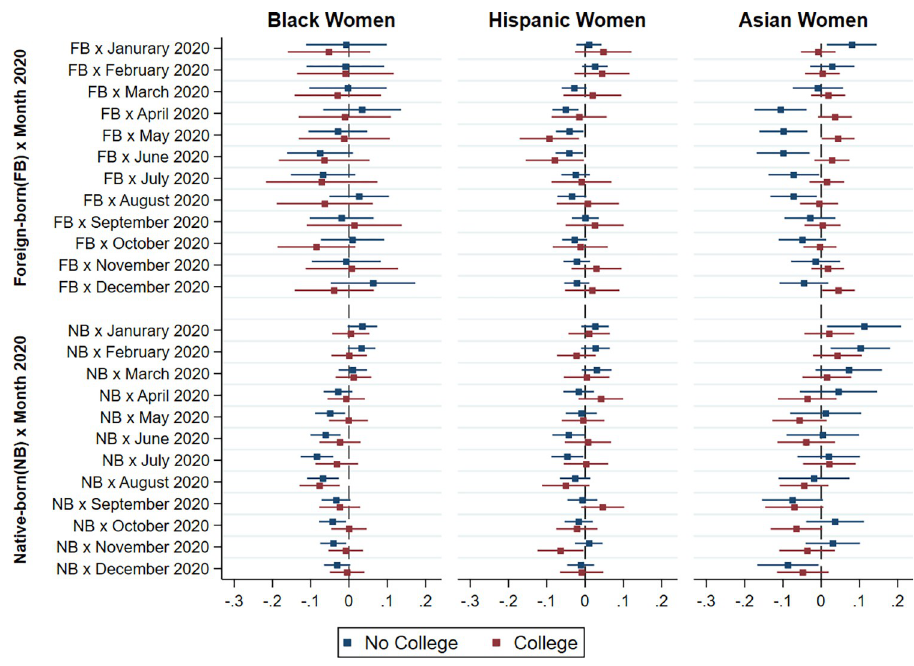
Fig 6. Difference in probability of full-time employment between non-White and native-born White women by immigrant status, race/ethnicity and education in 2020 relative to 2019.